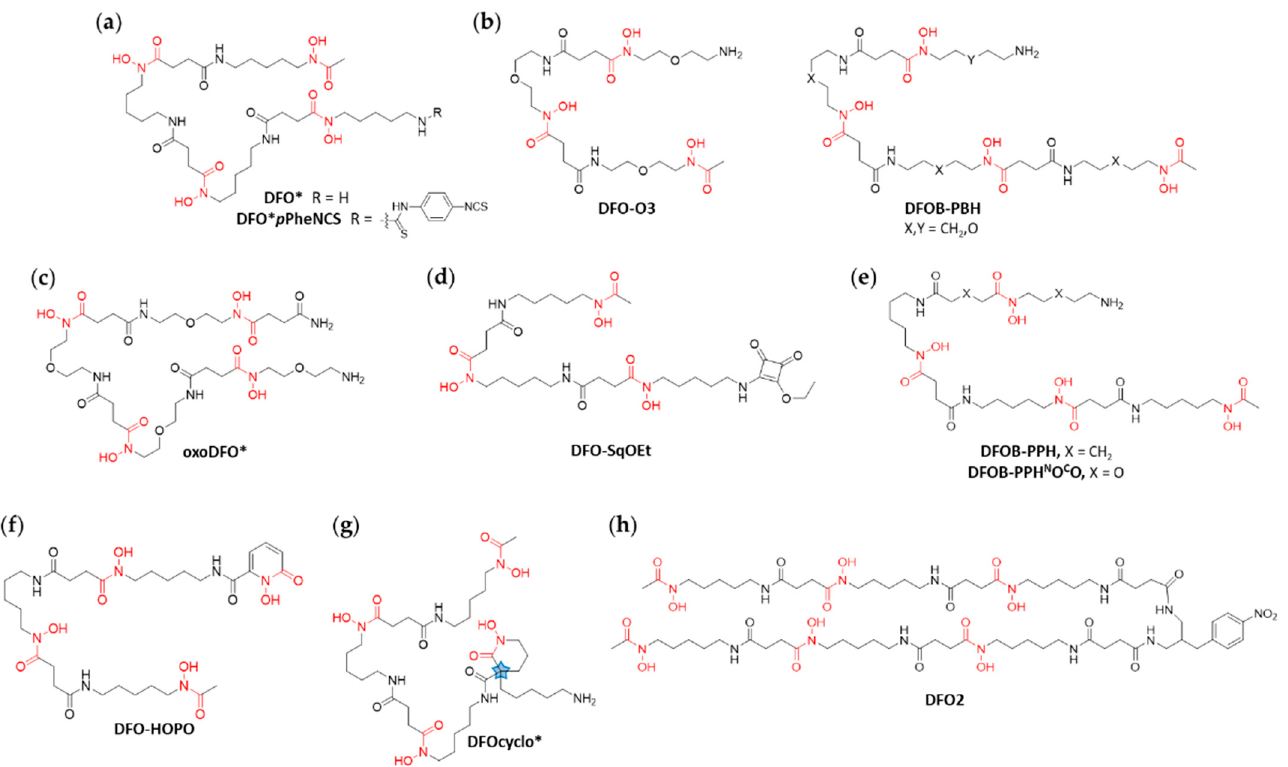
Figure 4. Structures of DFO derivatives. Additional hydroxamate moieties, compared to the three in DFO, lead to more stable metal-chelator complexes. ( a ) The octadentate DFO* extends the chain of DFO by one unit. DFO* p PheNCS is a bifunctionalized variant. ( b , c ) DFO-O3, DFOB-PBH and oxoDFO* contain oxygen in their backbones to increase hydrophilicity. ( d ) DFO-SqOEt uses a squaramide ester for bioconjugation chemistry and to increase its denticity. ( e ) DFOB-PPH and DFOB-PPH N O C O are linear tetrameric octadentate chelators. ( f ) DFO-HOPO is using a hydroxypyridinone moiety to extend the hexadentate DFO structure to an octadentate. ( g ) DFOcyclo* adds a cyclic hydroxamate motif to increase denticity. The blue star highlights the racemic center of the molecule. ( h ) DFO2 is a dimer of DFO ligands tethered together by a bifunctional linker.